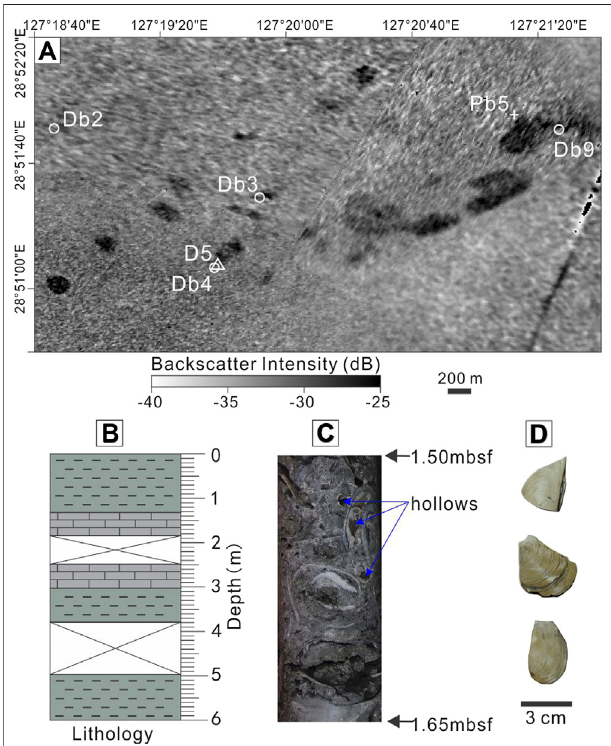
FIGURE8|(A) Zoom-in map of the backscattering intensity. Please note that D5 is located within the medium-to high-backscatter areas. (B) The recorded lithology of the sediment cores in the upper 6 m. The photos of the carbonate core (C) and the angular shells (D) are shown